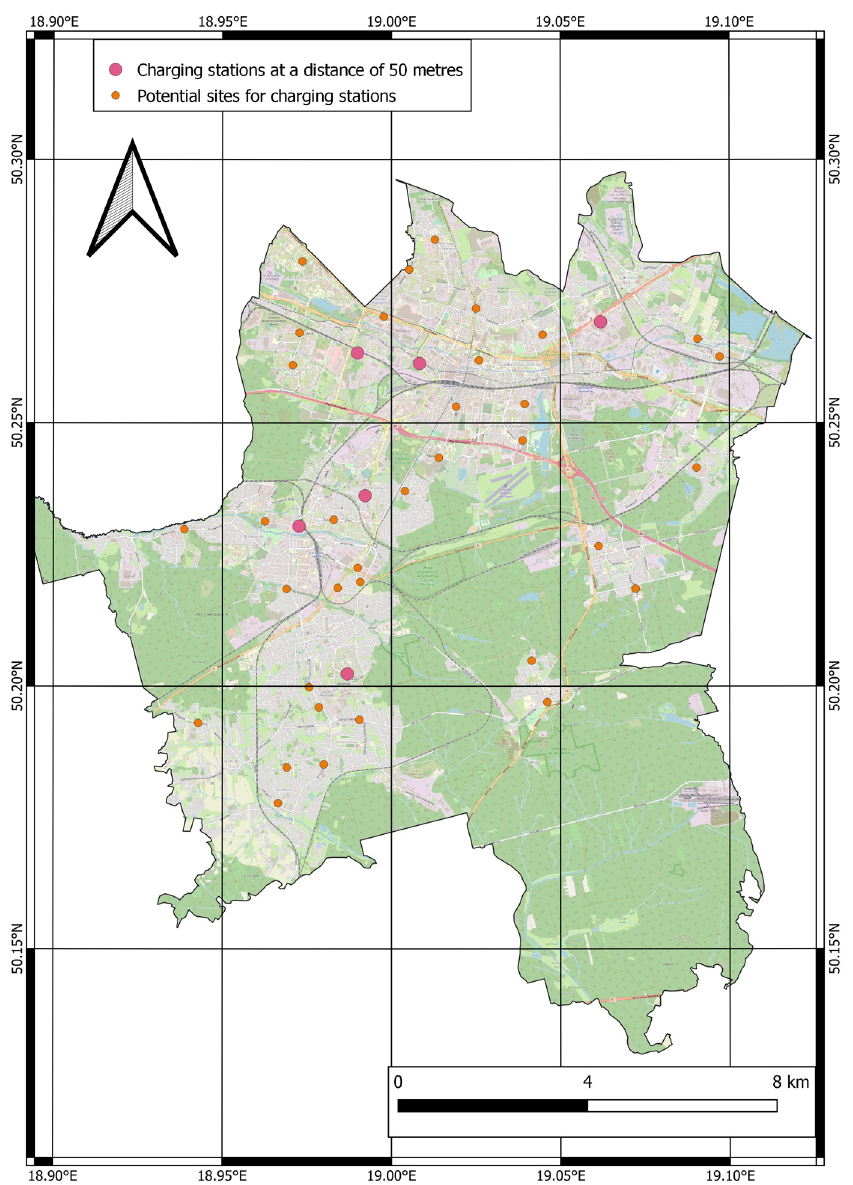
Figure 7. Location of 6 public stations meeting the distance conditions and 36 prospective sites with potential for the company’s new in-house charging stations.